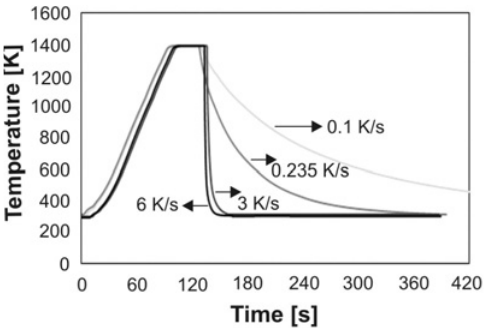
Figure 1. The different vacuum heat treatments with corre- sponding cooling rates.